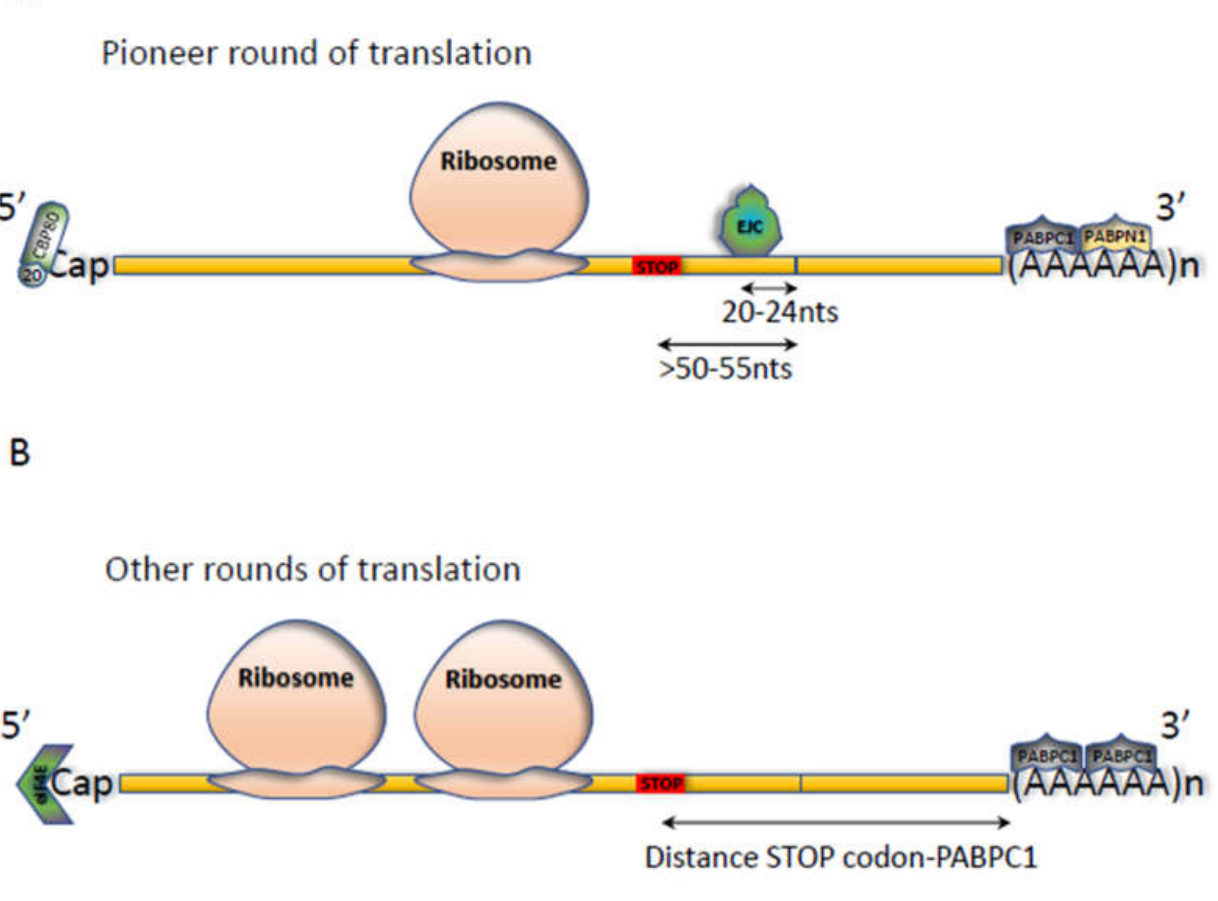
Figure 1. Rules for eliciting NMD according to the two models of NMD activation in human cells. ( A ) The EJC-dependent model. During the first round of translation (or the pioneer round of translation) when the CBP20 (20) -CBP80 heterodimer is present on the cap at the 5 (cid:48) end and the PABPC1 and PABPN1 proteins are bound to the poly (A) tail at the 3 (cid:48) end, a stop codon is recognized as a PTC if it is located more than 50 to 55 nucleotides upstream of an exon-exon junction. The presence of an EJC (exon junction complex) 20 to 24 nucleotides upstream of the exon-exon junction leads to recruitment of NMD factors when the ribosome reaches the PTC. Then NMD is activated and this mRNA is degraded; ( B ) The EJC-independent model. In this model, the distance between the first stop codon encountered by the ribosome and the PABPC1 determines whether this stop codon is premature or not.